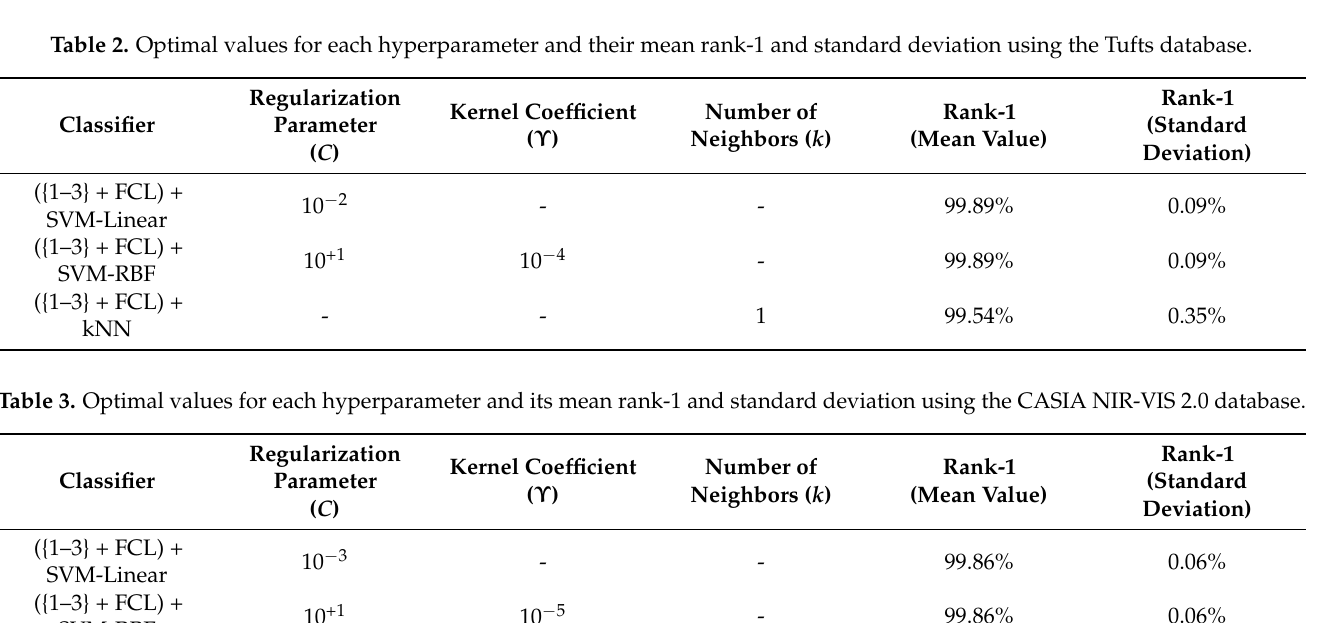
Table 2. Optimal values for each hyperparameter and their mean rank-1 and standard deviation using the Tufts database.